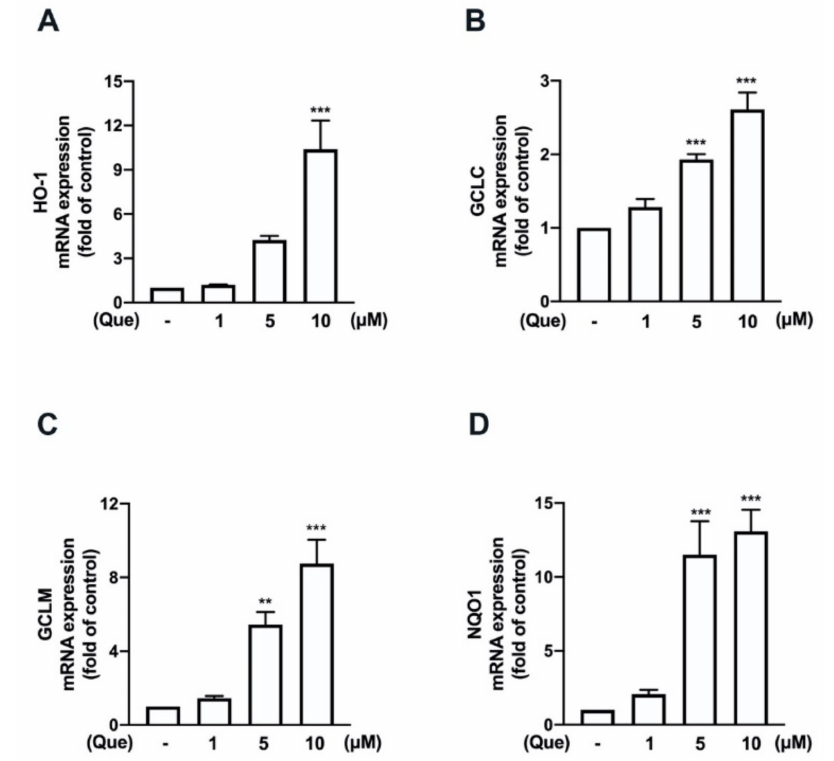
Figure 9. Effects of quercetin on the expression levels of endogenous antioxidants in microglial cells. IMG cells were stimulated with various concentrations of quercetin (1, 5, or 10 µ M) for 6 h. mRNA levels of heme oxygenase (HO)-1 ( A ), glutamate-cysteine ligase catalytic subunit (GCLC) ( B ), glutamate-cysteine ligase modifier subunit (GCLM) ( C ), and NAD(P)H quinone oxidoreductase-1 (NQO1) ( D ) were analyzed by real-time PCR and normalized to β -actin. Each bar represents the mean ± SEM of n = 3–4. Note: *** p < 0.005, ** p < 0.01, compared with the control